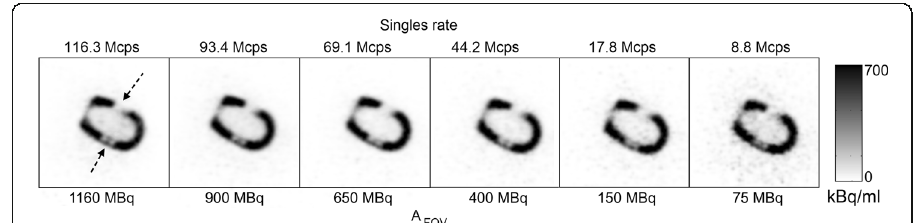
Fig. 3 Single reconstructed transaxial slice from a 5-s frame of the decaying phantom over a range of activities and singles rates showing the locations of the 2 fixed defects placed in the myocardial compartment. The defects showed the same spatial extent over all imaged activities. All images are shown with the same window width and level